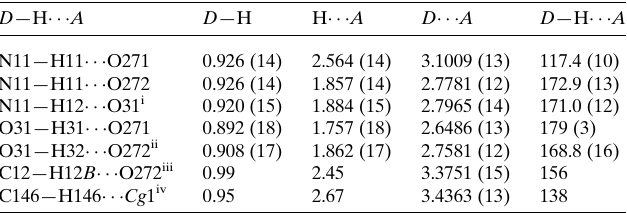
Table 1 Hydrogen-bond geometry (A˚ , (cid:3) ) for (I). Cg 1 is the centroid of the C21–C26